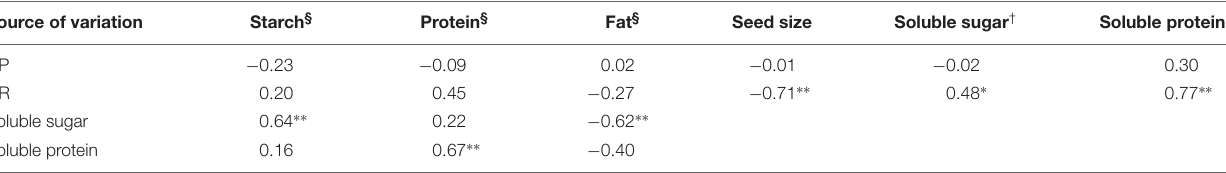
TABLE 2 | Correlation coefficients between germination and seed reserve contents. Source of